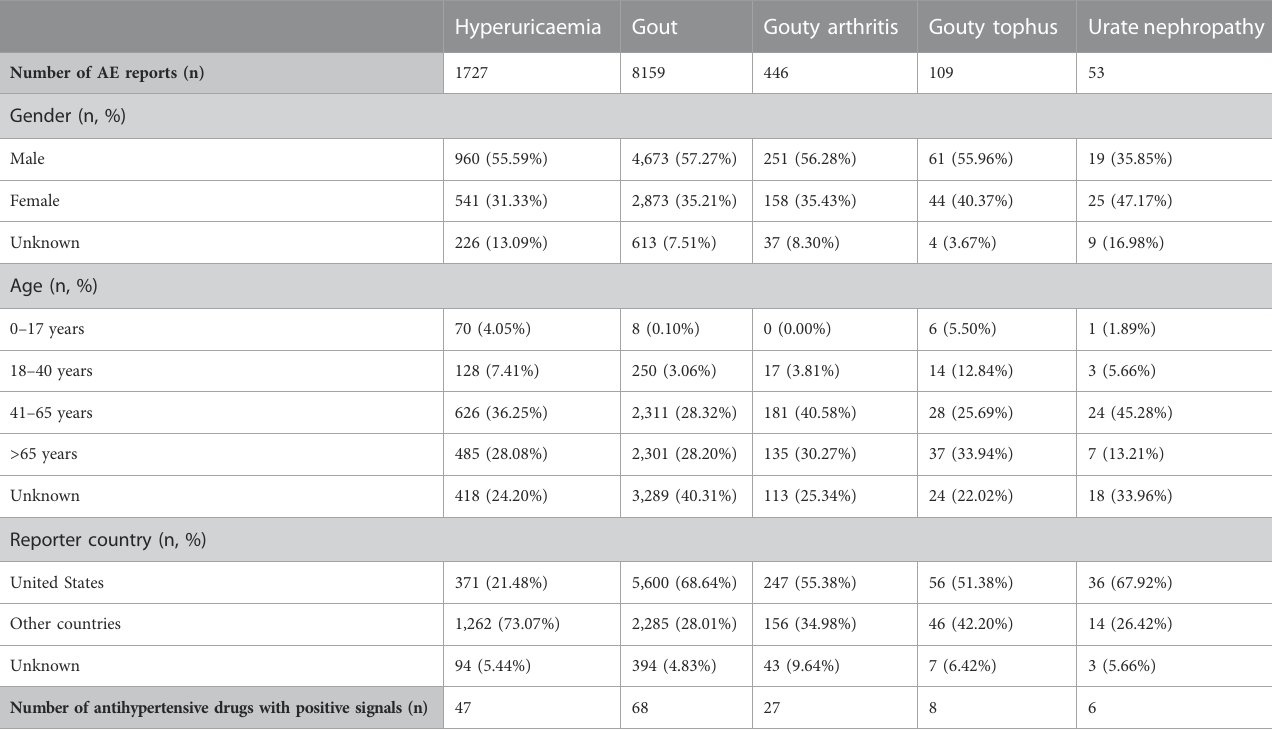
TABLE 1 Overview of AE reports submitted for hyperuricaemia, gout and related AEs in